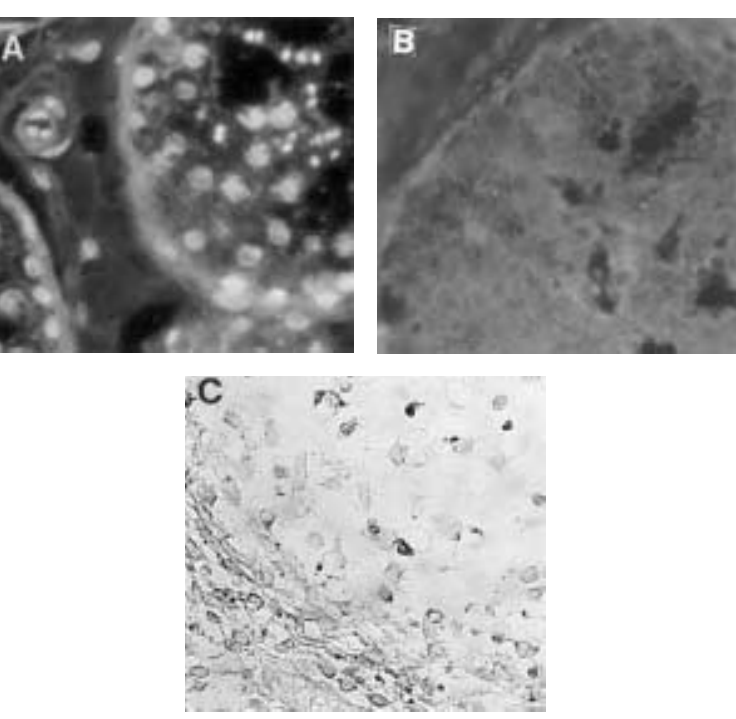
Fig. 6. A, Immunofluorescence of the anti-TK1 antibody in a paraffin embedded section from a normal human testis: the secondary spermatocytes are TK1 positive (Texas Red, red), cellular DNA (DAPI, blue); B, Immunofluorescence of the anti-TK1 antibody in a paraffin embedded section from a human poorly differentiated prostate carcinoma: tumor cell are TK1 positive (FITC, green), stroma cells are TK1 negative, cellular DNA (DAPI, blue); C, Immunoperoxidase stained mesodermic components from a malignant teratoma of a human